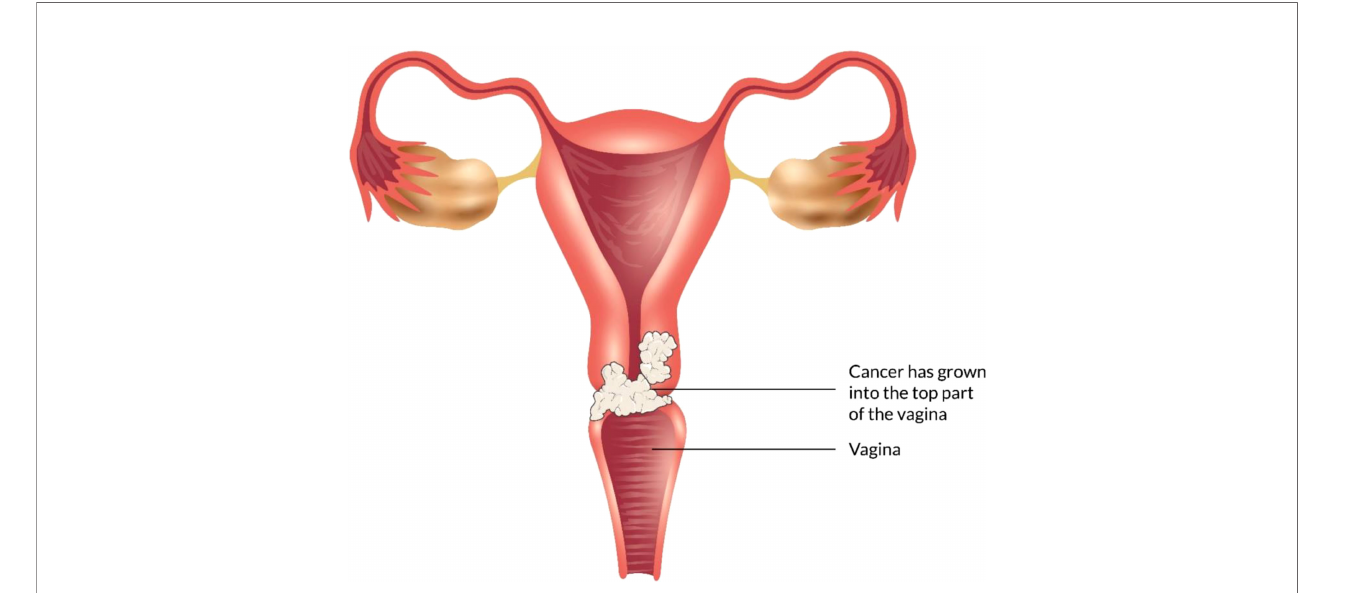
FIGURE 5 | Vaginal Cancer Stage